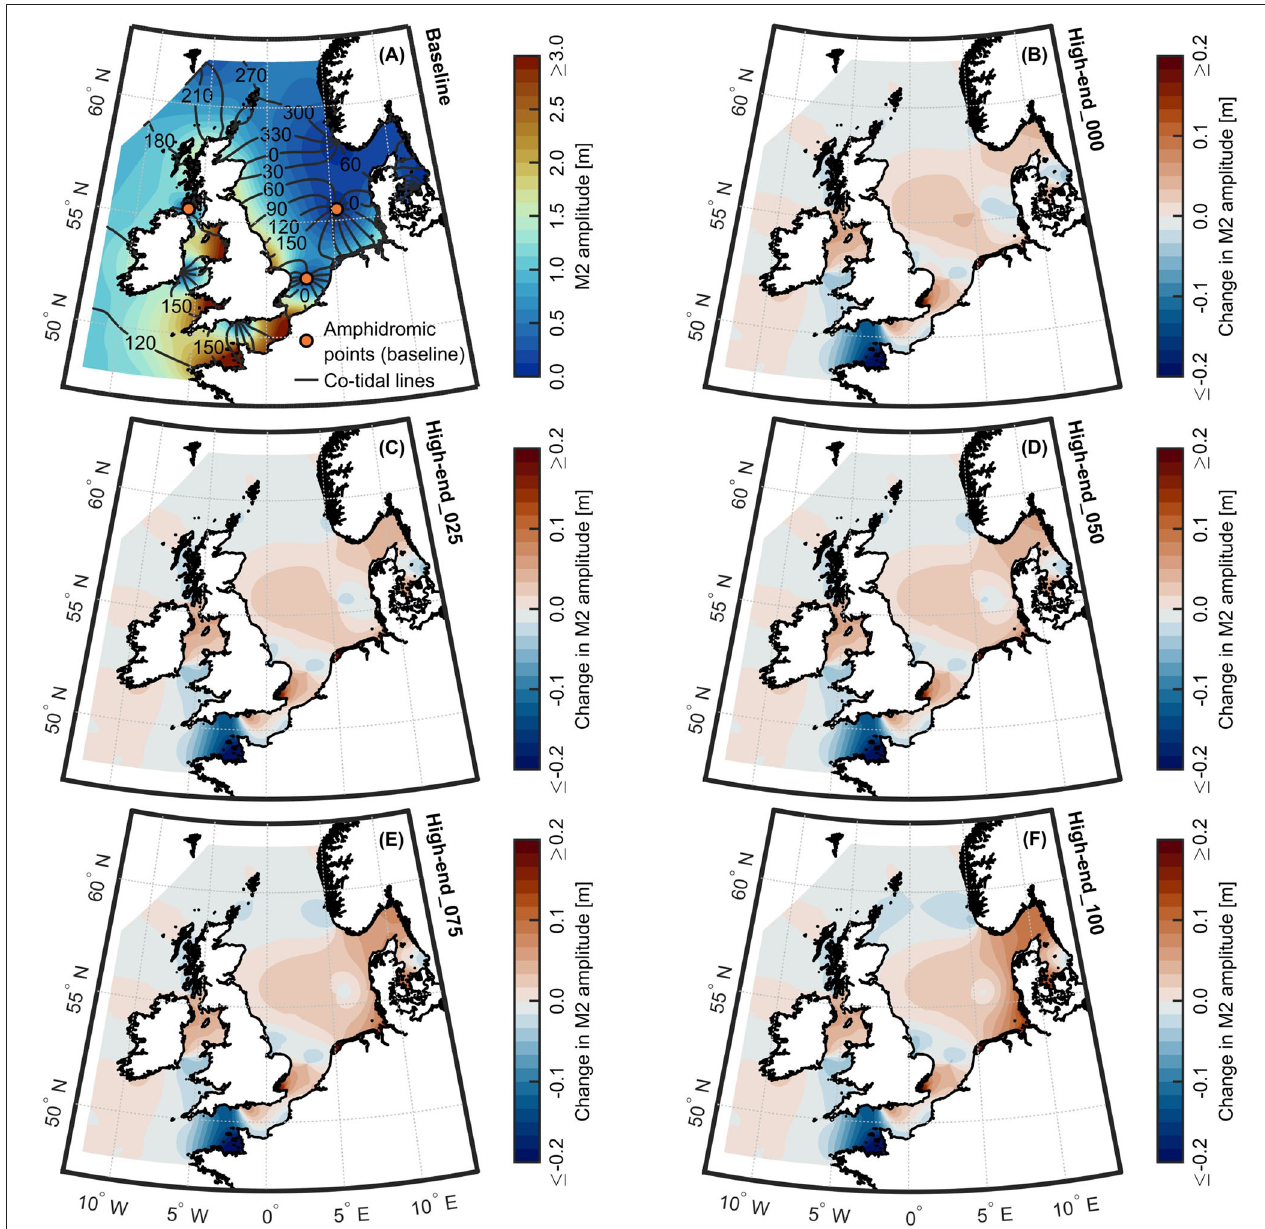
FIGURE 11 | M2 amplitudes for the NWES resulting from the combinations of 2.0m SLR projection and various cumulative rates of vertical accretion. (A) Map of M2 amplitudes for the NWES for the baseline scenario, according to the 3-month period from September 1 to December 1, 2012. Relative changes in M2 amplitudes for scenarios (B) high-end_000, (C) high-end_025, (D) high-end_050, (E) high-end_075, and (F)